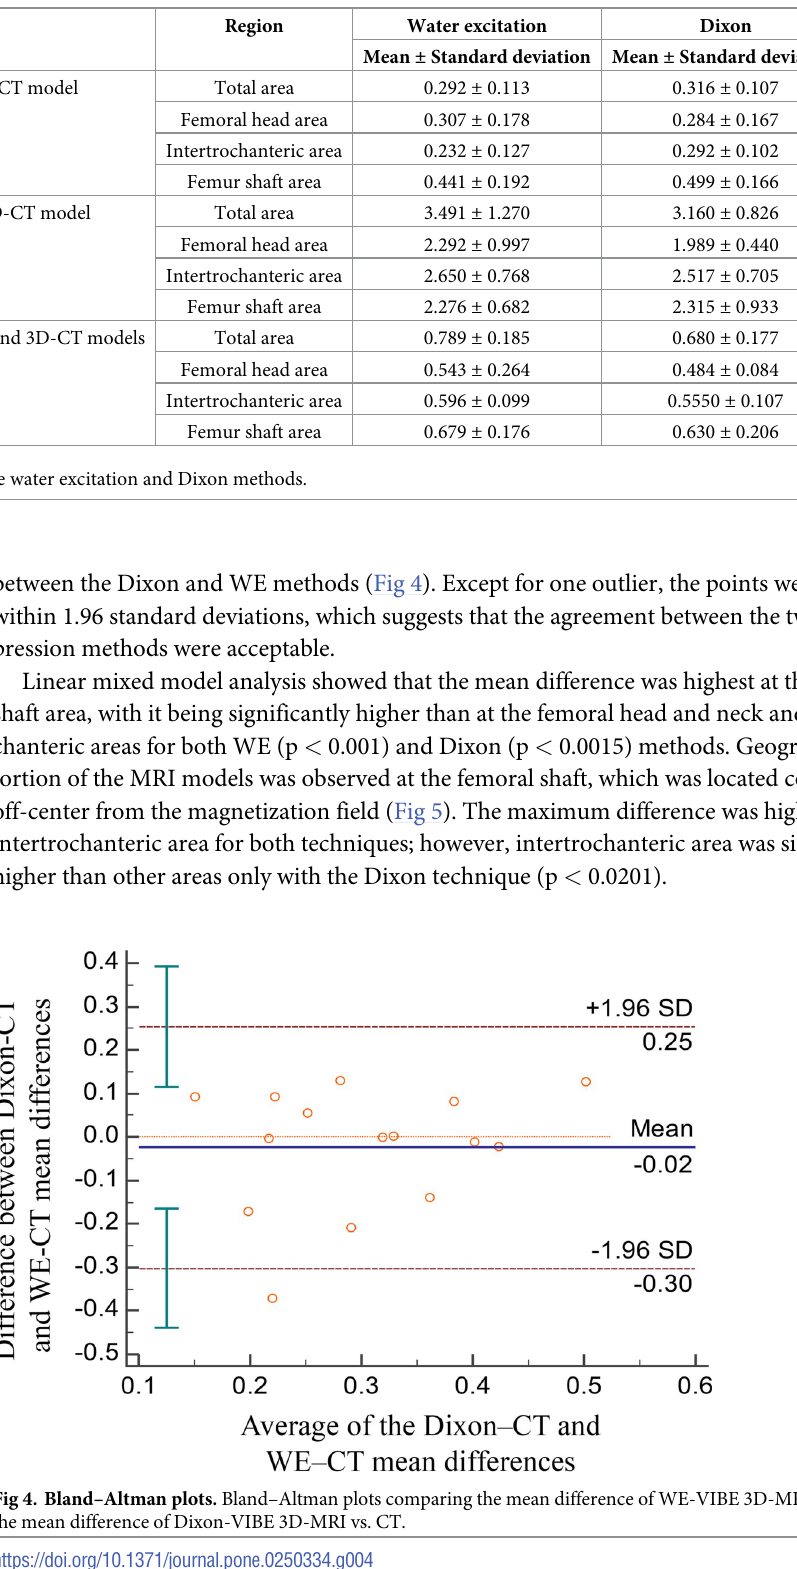
Table 4. Differences between the 3D-CT and 3D-MRI models with two different fat suppression methods (Dixon and water excitation).